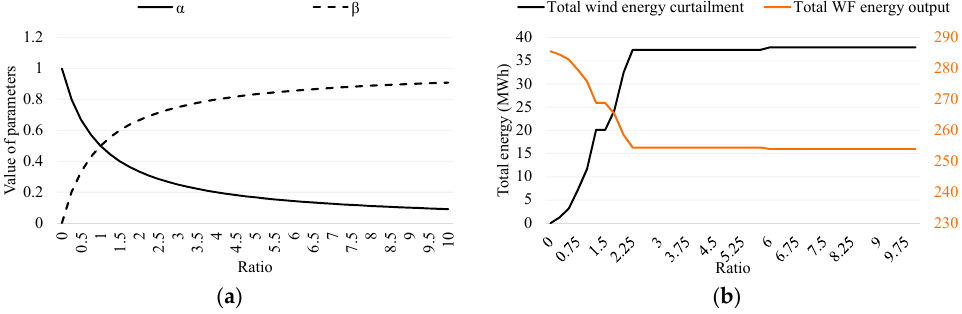
Figure 7. Effects of value of α on optimal results: ( a ) Output power of WF; ( b ) Output power deviation of WF; ( c ) Wind power curtailment. Figure 8. Effects of ratio ( β / α ) on optimal results: ( a ) Values of α and β ; ( b ) Output energy of WF and wind energy curtailment.